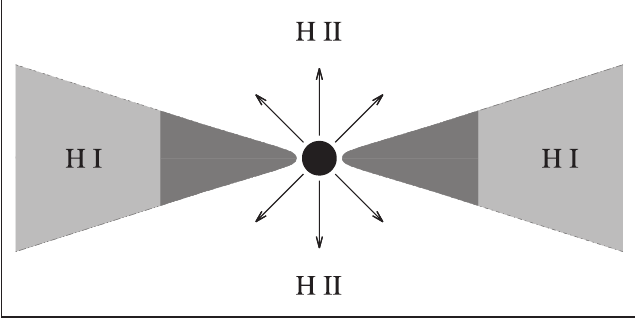
Fig. 3. An example of the ionization structure in the enhanced wind from the hot star during an active phase calculated for v rot = 200 km s − 1 and X = 400. The hot star is denoted by the black filled circle and the neutral zone (H I) is shown in grey. Its shape resembles a flared disk. The optically thick part of this neutral zone is shown in dark grey. The boundary between the grey and dark grey regions mimics the false photosphere. In the symbiotic binaries with a high orbital inclination we are looking at this false photosphere, which radiates at significantly lower temperature than the central hot star. The ionized zone (H II) is located above and below the neutral disk-like structure and can be associated with the hot star wind (black